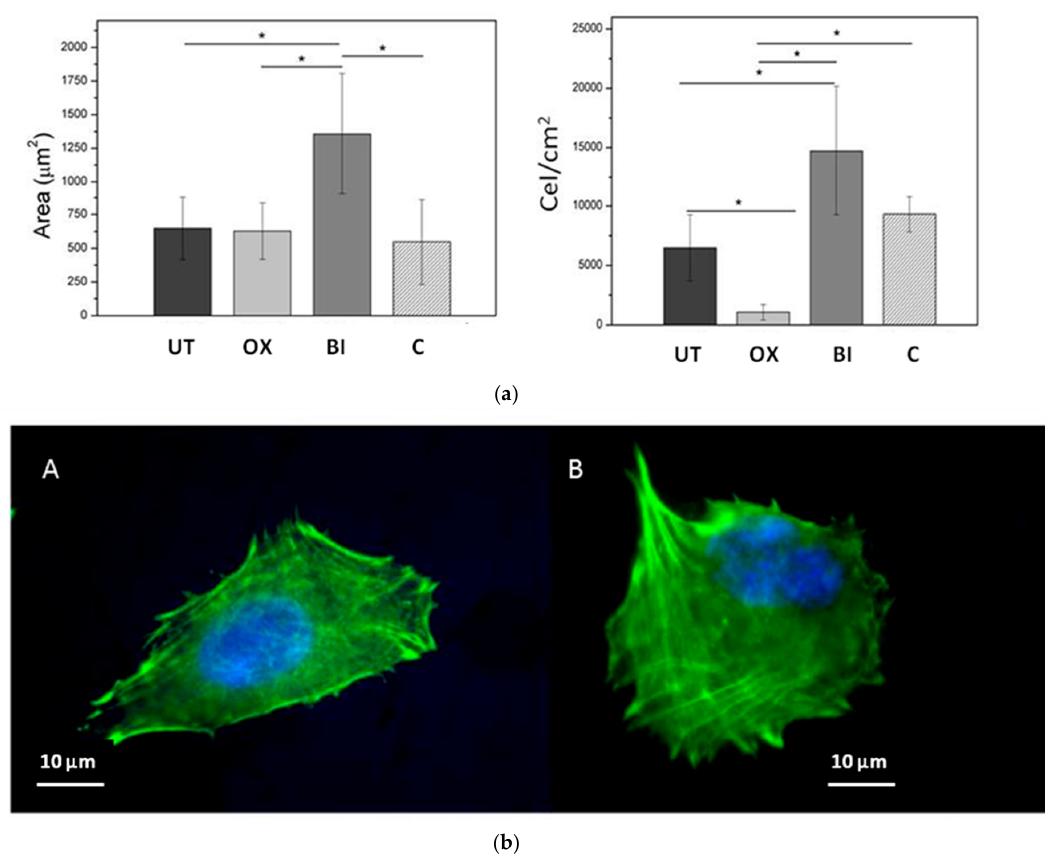
Figure 4. ( a ) Cell spreading and cell number after 2 h of culture corresponding to different surfaces: C , Teflon; UT , untreated Ti; OX , oxidized Ti; and BI , bioactive Ti; ( b ) Representative fluorescence microscopy images of MG63 cells on untreated NiTi ( A ) and bioactive NiTi ( B ) after seven days of incubation (alloy A).